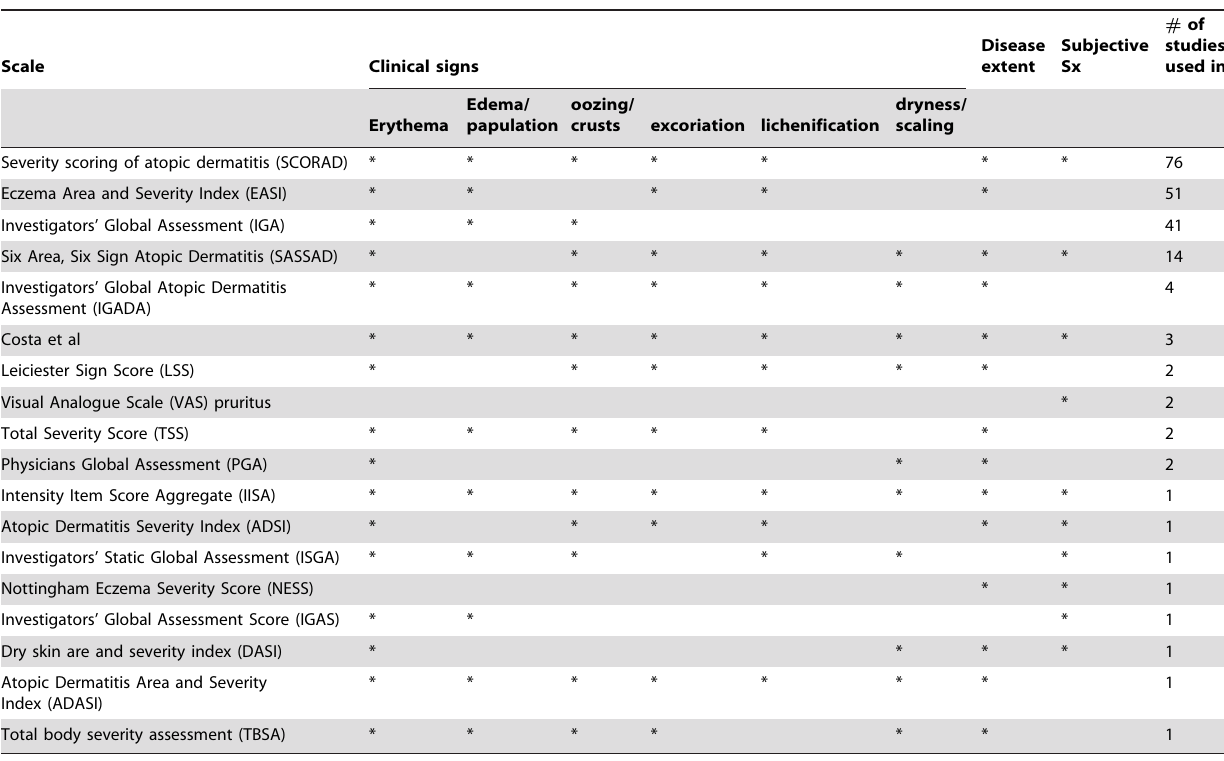
Table 1. Severity of disease